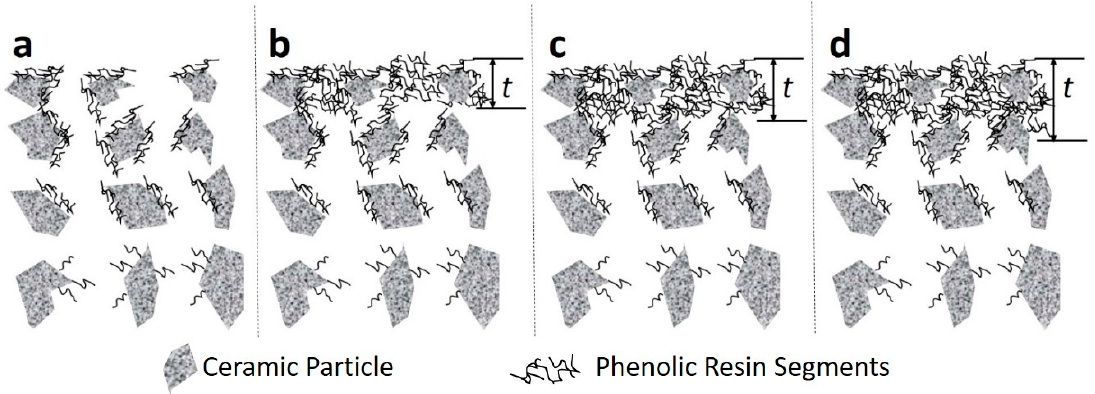
Figure 6. Idealized schematic of the vacuum-assisted phenolic impregnation method for the S-T substrates ( a ) first impregnation, and second impregnation for phenolic resin concentrations of ( b ) 1 wt %, ( c ) 5 wt %, and ( d ) 10 wt % and the phenolic resin thickness ( t ).